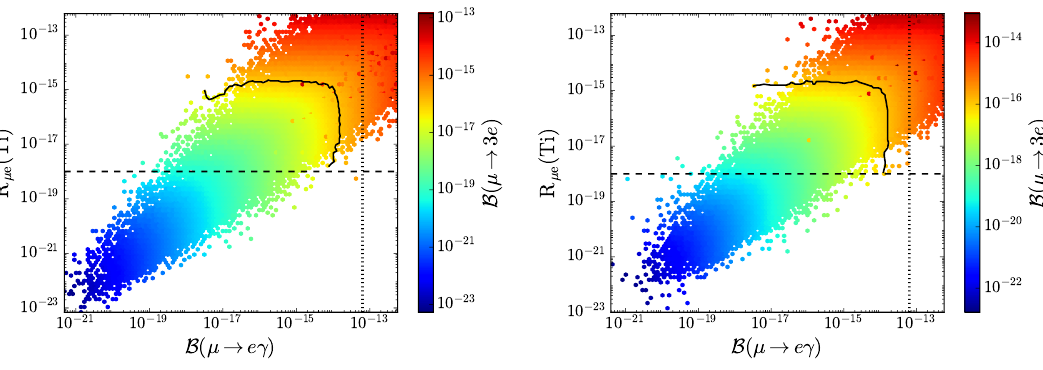
Figure 5 . The available parameter space of the IZM and the future exclusion zones coming from the most constraining CLFV searches. Left (right) panel is for NH (IH). The dotted, solid and dashed lines represent the expected sensitivity for the future searches regarding B ( (cid:22) ! e(cid:13) ), B ( (cid:22) ! 3 e ) and R (cid:22)e ,